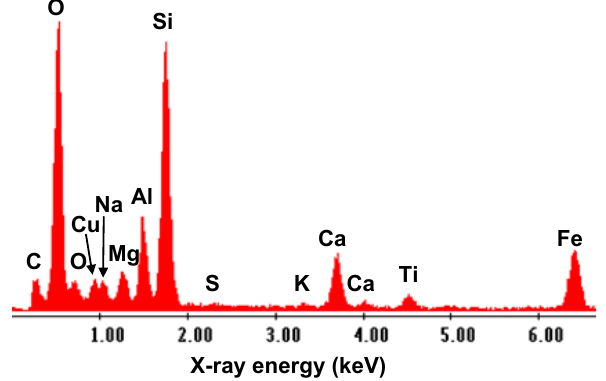
Fig. 9. An EDX spectrum of a typical particle from the group 1, Figure 9. An EDX spectrum of a typical particle from the group 1, i.e. pure volcanic ash i.e. pure volcanic ash particle. C and Cu peaks originate from TEM particle. C and Cu peaks originate from TEM grid substrate. grid